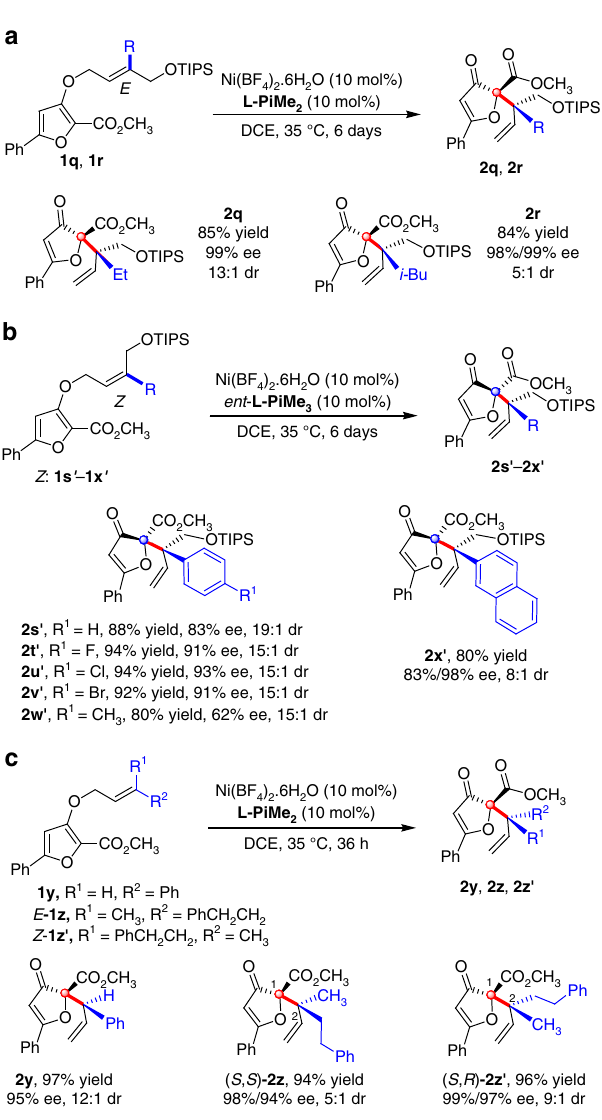
Fig. 3 Substrate scope with variations at alkene unit. a Substrate scope of E - alkyl substituted alkene. b Substrate scope of Z -aryl substituted alkene; c Substrate scope of mono- and disubstituted alkene. The reactions were performed with 1, Ligand/Ni(BF 4 ) 2 · 6H 2 O (1:1, 10 mol%), in DCE at 35 °C for indicated time. Isolated yield. The dr value was determined by 1 H NMR